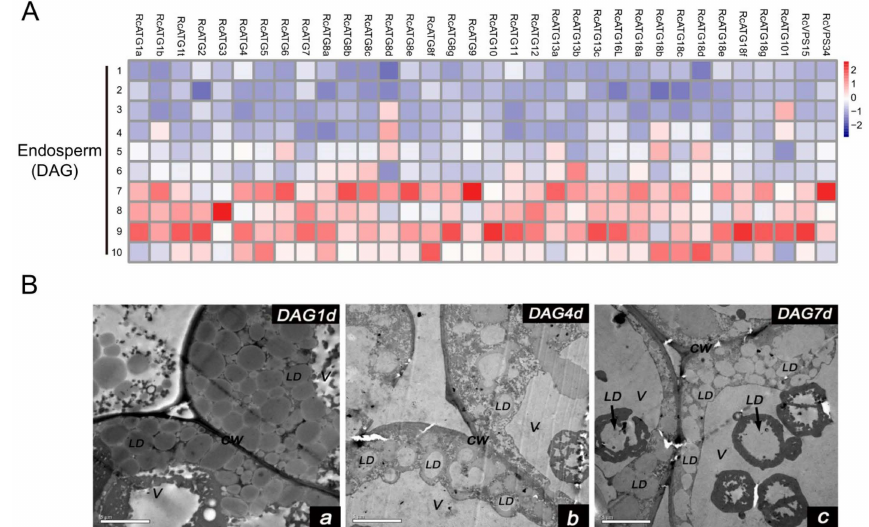
Figure 6. ( A ) Expression profiles of RcATGs in germinating endosperm. The expression profile was constructed depending on the relative expression level of RcATGs at di ff erent germination stages (DAG: days after germination). The expression is normalized to RcACTIN2 and the data are means ± S.D. from three biological replicates. Blue boxes indicate the lower transcriptional level of RcATGs and red boxes indicate the higher expression level of RcATGs . The scale bar represents relative expression level after normalization. ( B ) Transmission electron microscopy of germinating endosperm (LD: lipid droplets; V: vacuole; CW: cell wall). a: DAG1d, b: DAG4d, c: